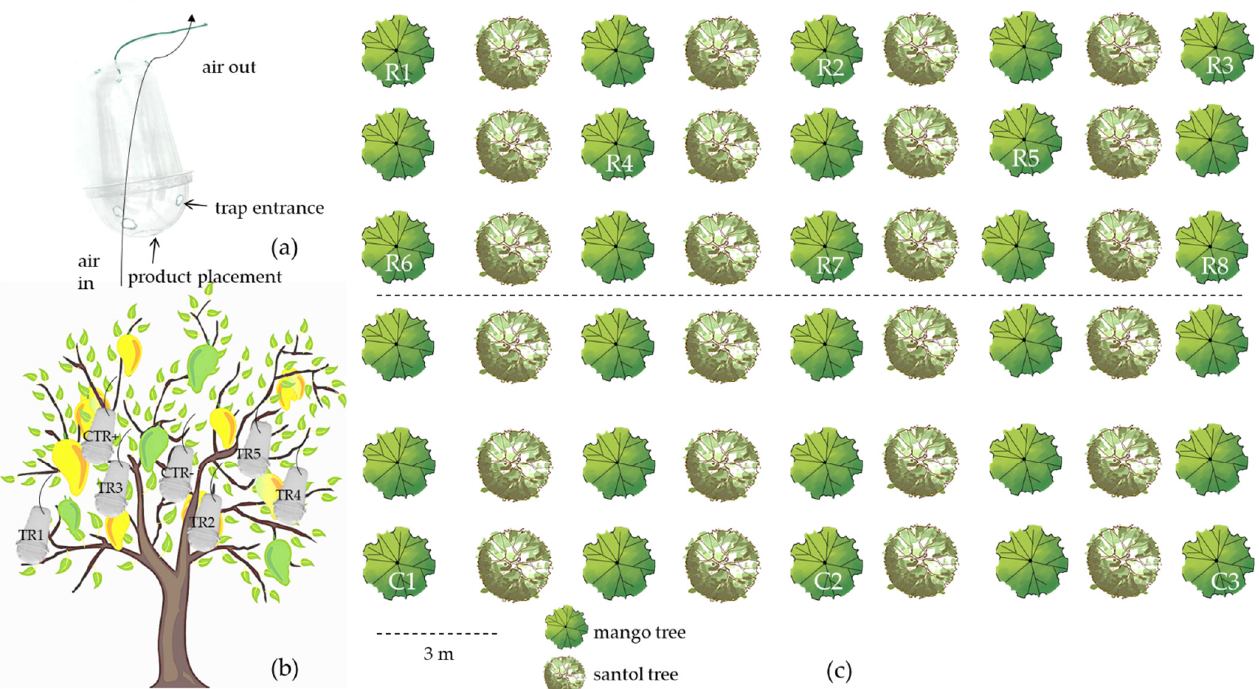
Scheme 2. Field study of the Oriental fruit fly traps with encapsulated products during mango var. nam dok mai harvesting season. ( a ) Trap and ( b ) Trap hanging inside the canopy; TR1 = MD100, TR2 = GA100, TR3 = MD50GA50, TR4 = MD75GA25, TR5 = MD25GA75, CTR+ = white holy basil essential oil, and CTR- = no test solution ( c ) Experimental arrangement; R1–R8 as trap replications 1–8, and C1–C3 as traps with the commercial fruit fly attractant